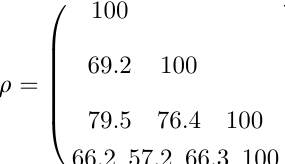
Alongside factors f 1 , ... , f n and ~ f ~ δ (Y) = 32 .